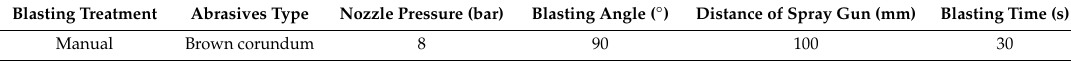
Table 2. Main parameters of the grit-blasting treatment.